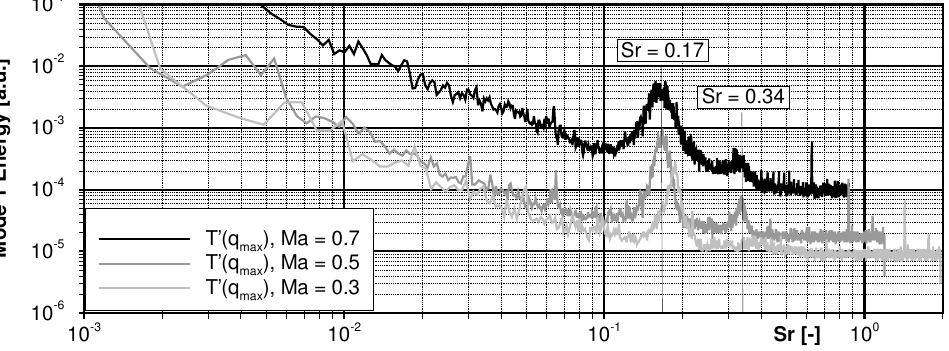
Figure 7. Mode 1 energy spectra for all inflow Mach numbers calculated by means of a spectral proper orthogonal